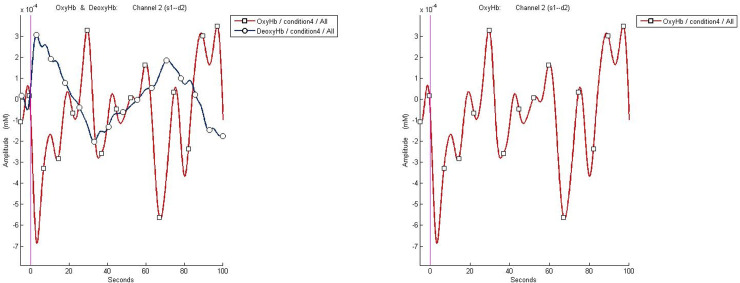
Processed HbO/Hb concentration (left) and HbO concentration (right) for one condition in a single NIRS channel.